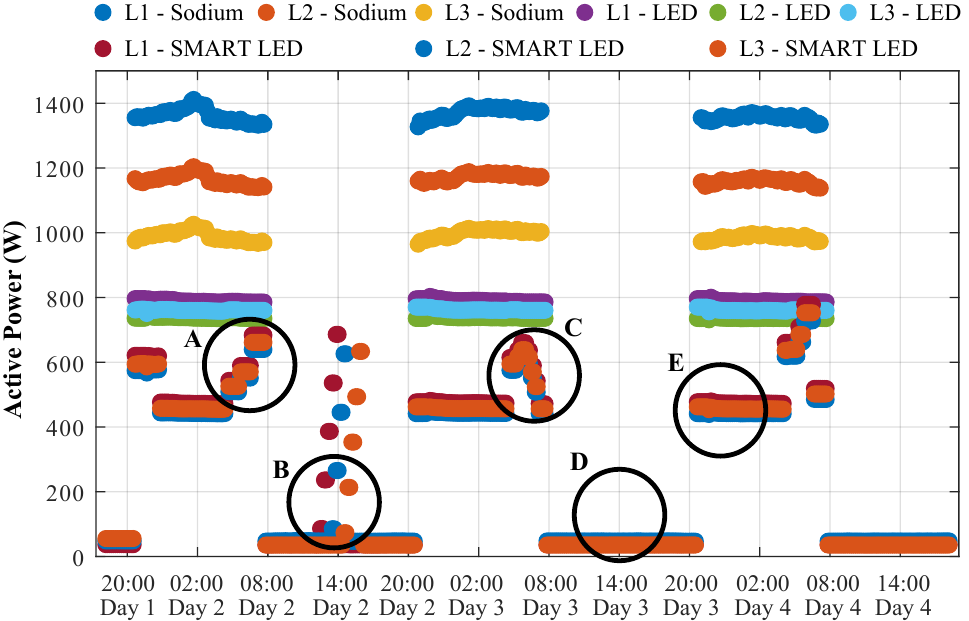
Figure 18. Comparison of various types of